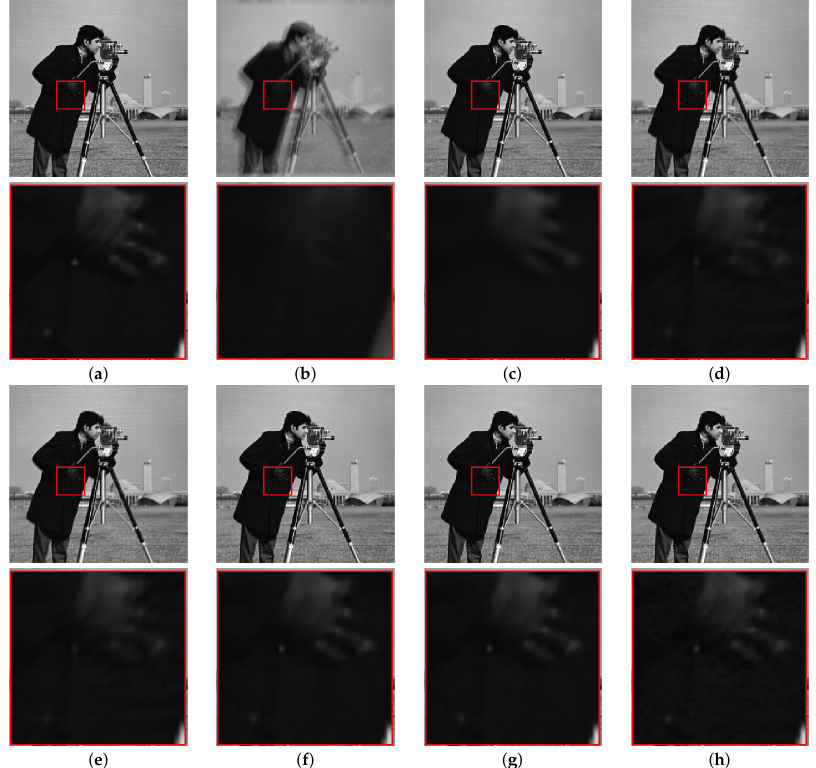
Figure 3. The cameramen image restored by all algorithms. ( a ) Cameramen, ( b ) degraded, ( c )